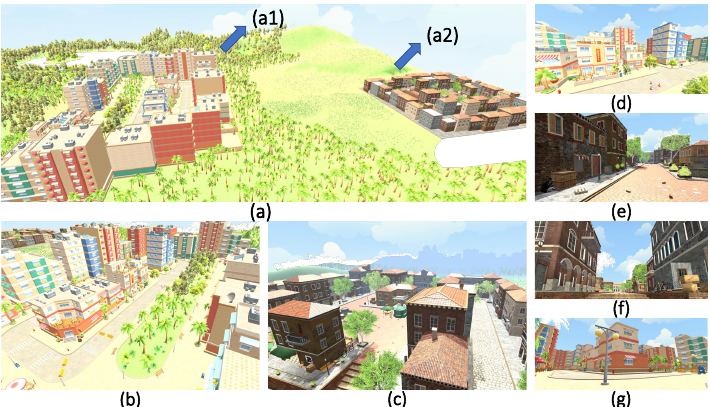
Figure 3. Modern and historical city views designed in the unity game engine—virtual environments: ( a ) Game engine terrain of all design. ( a1 ) Modern city design. ( a2 ) Old city design. ( b – g ) City views from different angles.